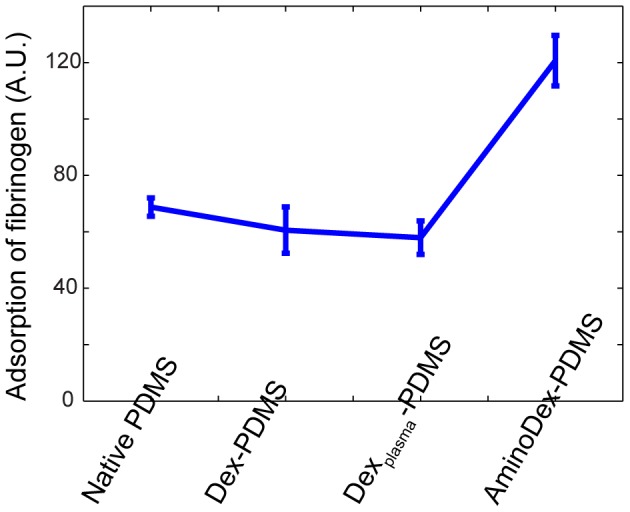
Adsorption characteristics of various formulations of dextran-PDMS (60∶1).Unmodified dextran-embedded PDMS possesses similar adsorption to native PDMS, while amino-modified dextrans heavily adsorb fibrinogen.